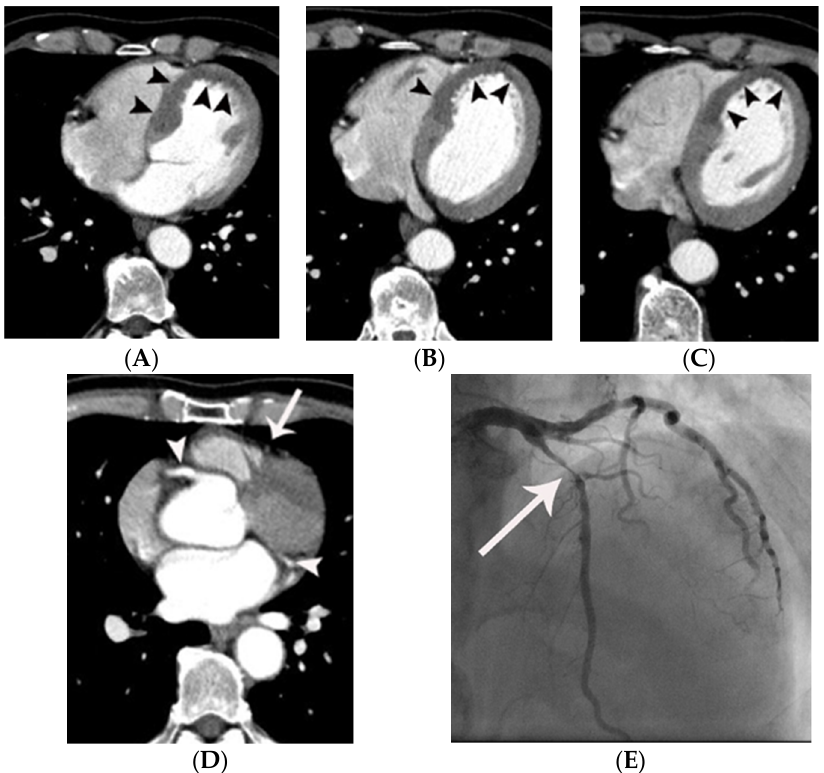
Figure 1. Representative case, demonstrating probable MPD in a 69-year-old male with acute chest pain. Subendocardial or transmural hypoattenuation (arrowheads in ( A – C )) was demonstrated on the multiple non-gated axial CT images along the left anterior descending coronary territory (i.e., antero-septum and the left ventricular apex). Note that attenuation of the mid-left anterior descending coronary artery (arrow in ( D )) is low compared to the right coronary artery and left circumflex coronary artery (arrowheads in ( D )), suggesting critical narrowing or occlusion of the left anterior descending coronary artery. Critical narrowing in the proximal left anterior descending coronary artery was confirmed on subsequent coronary angiography (arrow in ( E